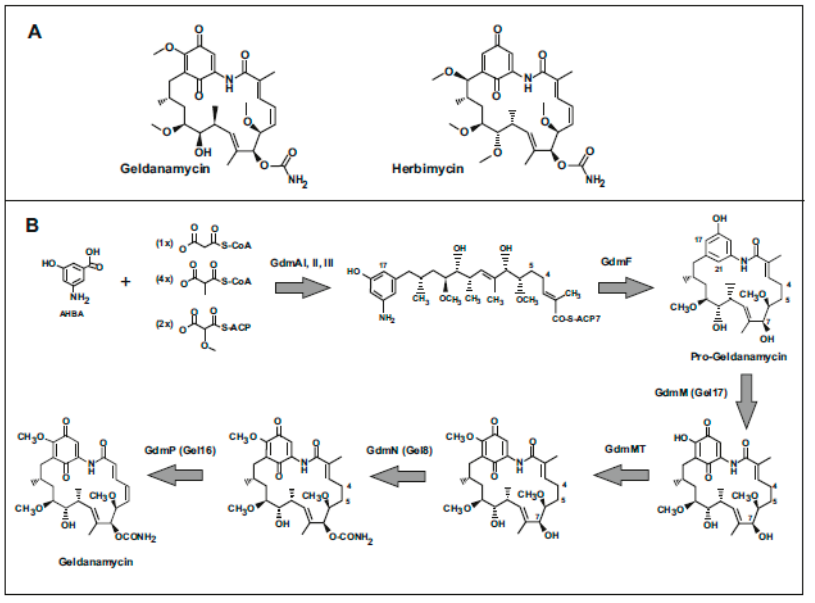
Figure 1. Geldanamycin structure and biosynthesis pathway. ( A ) Structures of geldanamycin and herbimycin. ( B ) Geldanamycin biosynthetic pathway. The enzymes involved in every step are indicated. Table 1. Strains producers of geldanamycin.